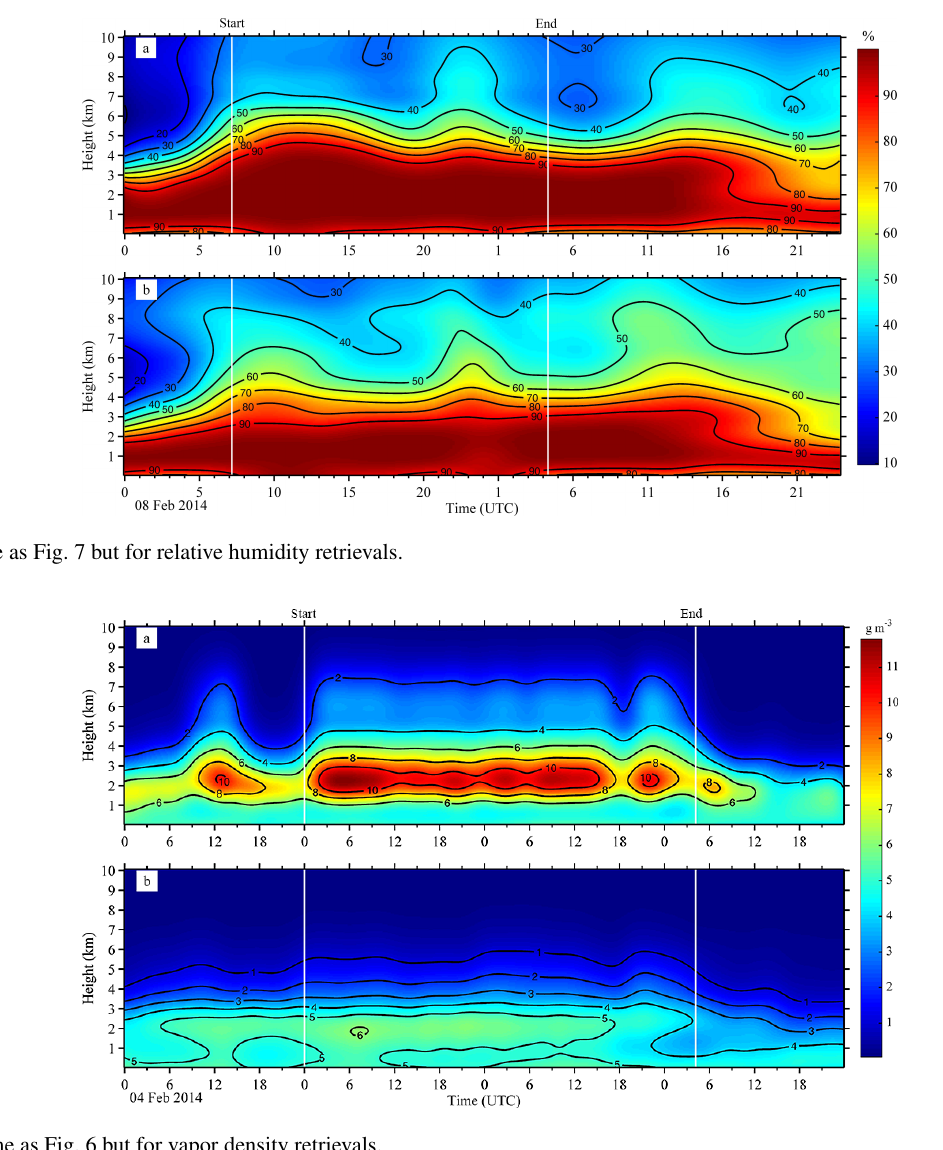
Figure 10. Same as Fig. 6 but for vapor density